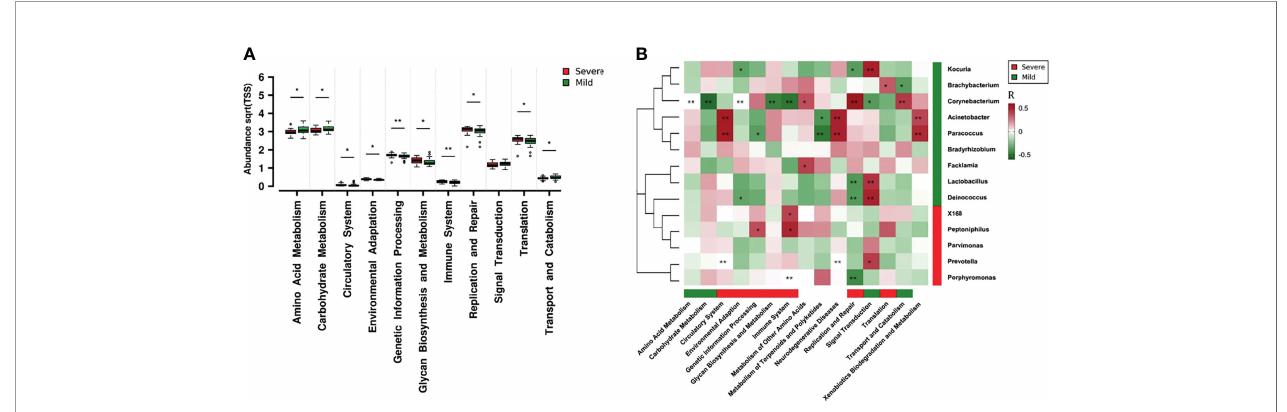
FIGURE 5 | Dermic microbial function comparison of paronychia in patients with different in fl ammation severities and their relationship with the core microbiome. (A) Functional analysis was performed at the KEGG second hierarchy level in the dermic microbiota. Wilcoxon test was applied to compare each category of microbial function, and results with P < 0.05 were considered statistically signi fi cant. (B) Heatmap of correlation between the core microbiome and key metabolic pathway in the dermis of patients with mild paronychia. Core genera of dermic microbiome and their correlations with the 15 discrepant metabolite pathways in different groups were analyzed using Pearson correlation analysis. The Pearson correlation coef fi cient between the genus and the metabolic pathway was calculated; it is shown in a colored matrix. Red square represents a positive correlation, whereas green square represents a negative correlation. Red bar means the marked functions and genera were higher in the severe patients whereas green bar means the marked functions and genera were higher in the mild patients, with white bar indicating no signi fi cant difference between the groups.* P < 0.05, ** P <